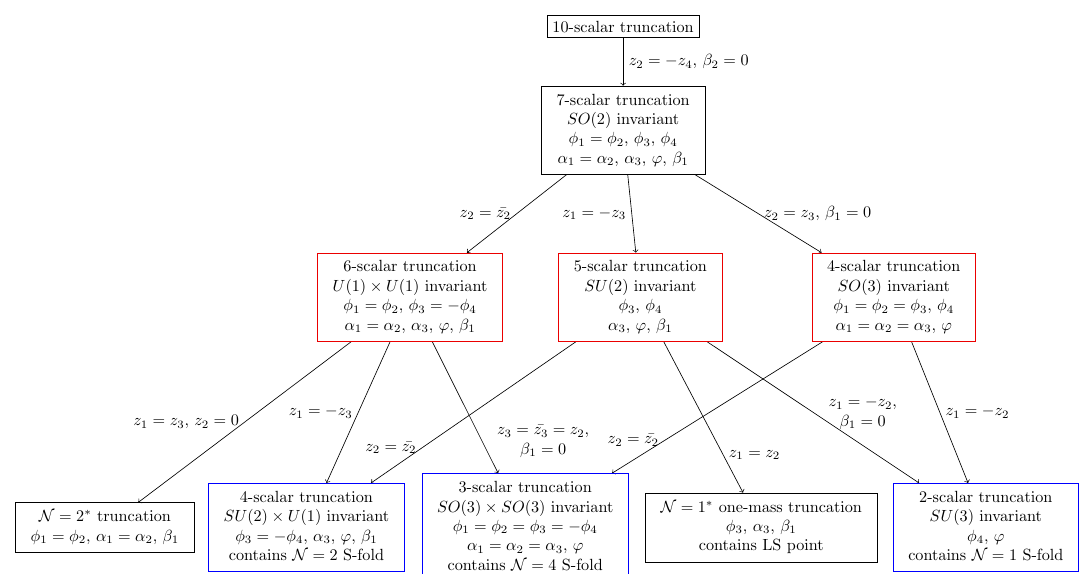
Figure 1 . Various sub-truncations of the 10-scalar model in D = 5 . The boxes with the blue outline are truncations that contain known AdS 4 × R S-fold solutions with a linear dilaton. The new one parameter family of S-folds, containing both the N = 2 and N = 4 S-folds, is contained in the U(1) × U(1) invariant 6-scalar truncation. Various RG flow solutions are discussed for the truncations in the blue and red